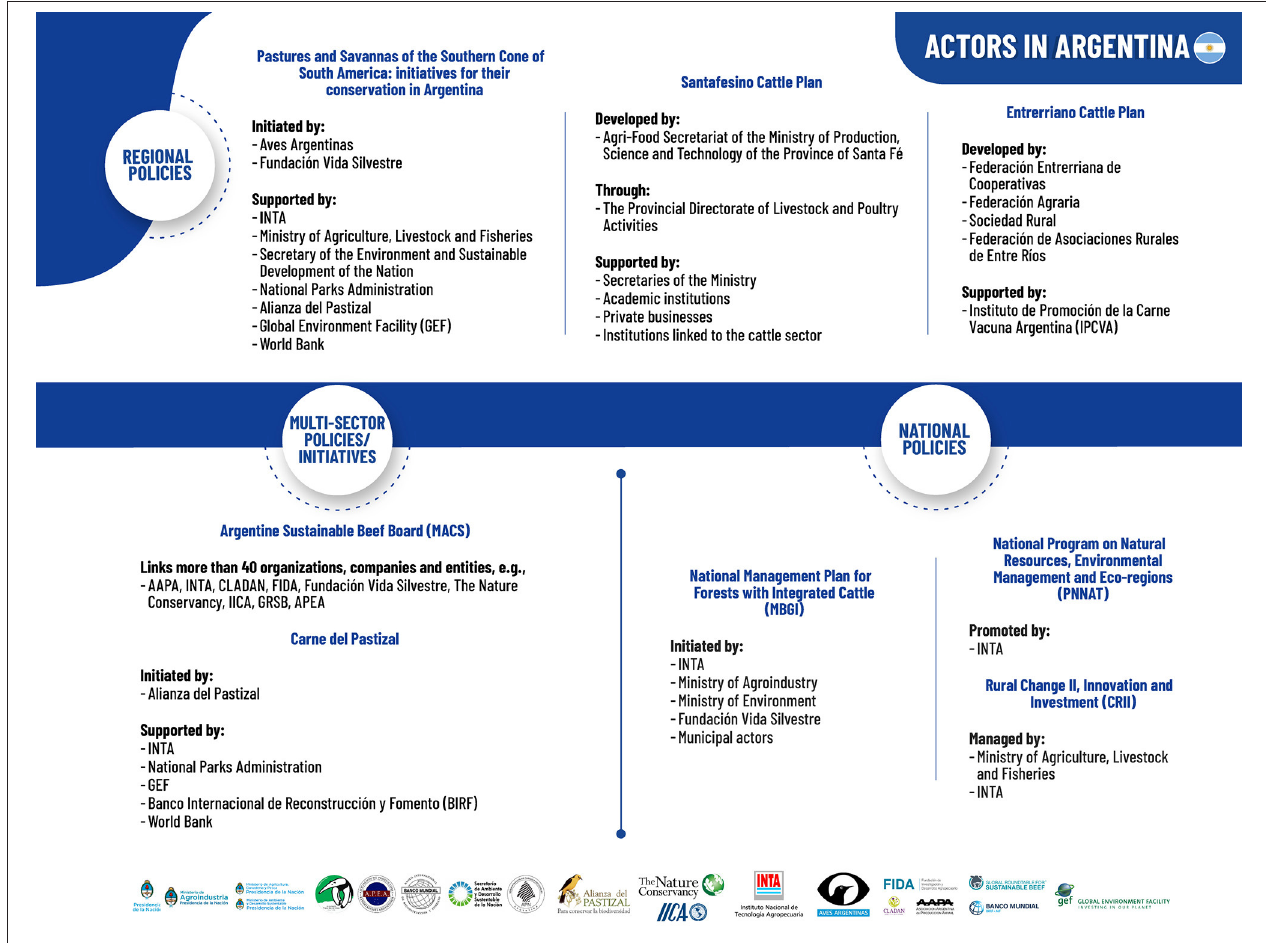
FIGURE 2 | Actors involved in the design and execution of public policies in Argentina.